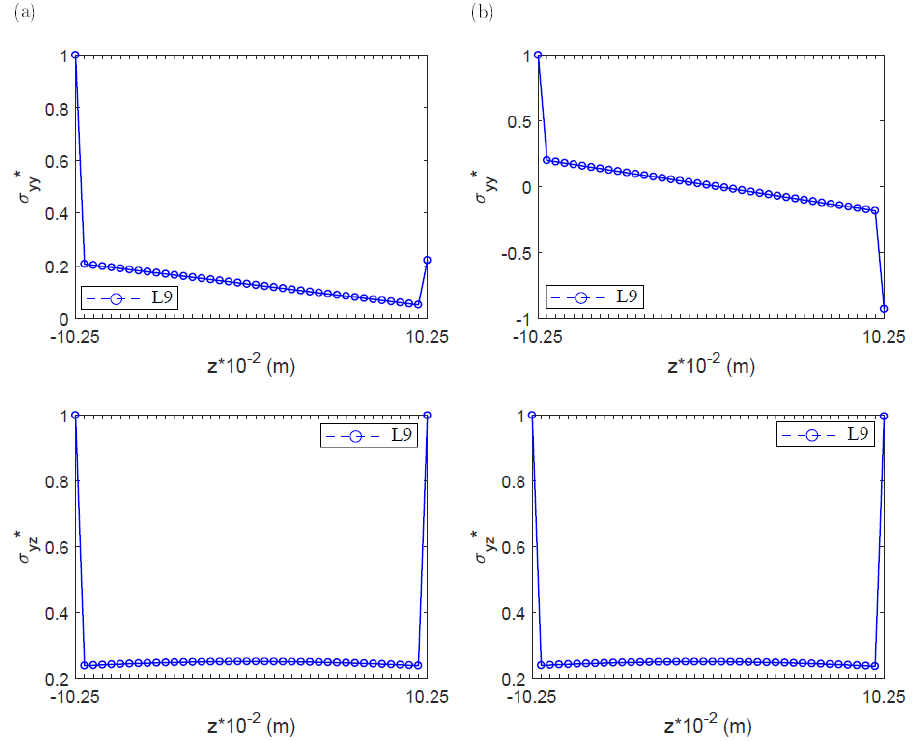
Figure 23. Distribution of axial and shear stress components for NL regime at x = − a 2 /2 and y = L /2 for L9 for ( a ) P ∗ = − 0.057 and ( b ) P ∗ = − 0.1029 in the two-cell FG beam subjected to axial loading for m = 5.0, ( σ ∗ yy = σ yy / σ yy and σ ∗ yz = σ yz / σ yz ). max max